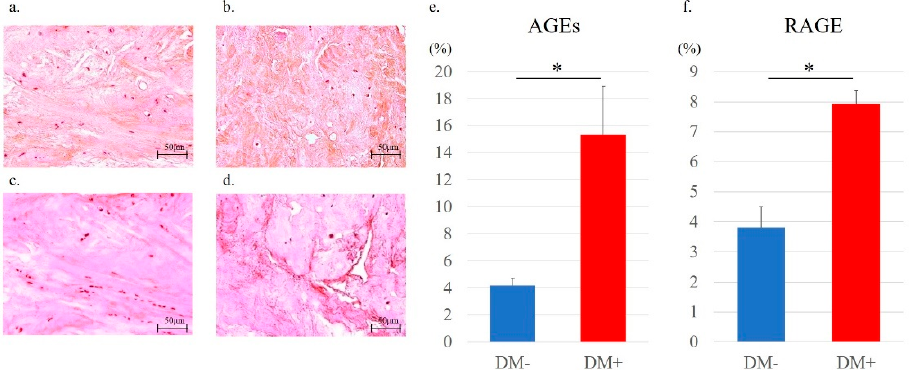
Figure 8. Immunohistochemistry staining for the detection of the expression of AGEs in the supraspinatus tendons in the non-diabetic controls ( a ) and diabetic group ( b ). The red-stained regions represent AGE-positive areas. Immunohistochemistry staining for the detection of the expression of RAGE in the supraspinatus tendons in the non-diabetic ( c ) and diabetic groups ( d ). The red-stained regions represent RAGE-positive areas. Quantitative analysis of the regions expressing AGEs ( e ) and RAGE ( f ). The percentages of AGEs and RAGE-positive regions were calculated by averaging the five selected fields at random per histological section. Data are presented as the mean ± SD. The independent t -test was performed for determining significant differences: * p <